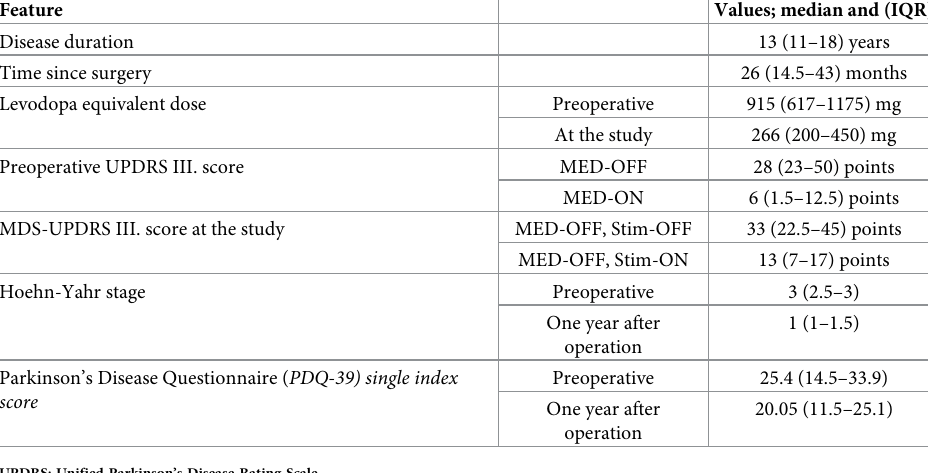
Table 2. Demographics and clinical data of the recruited